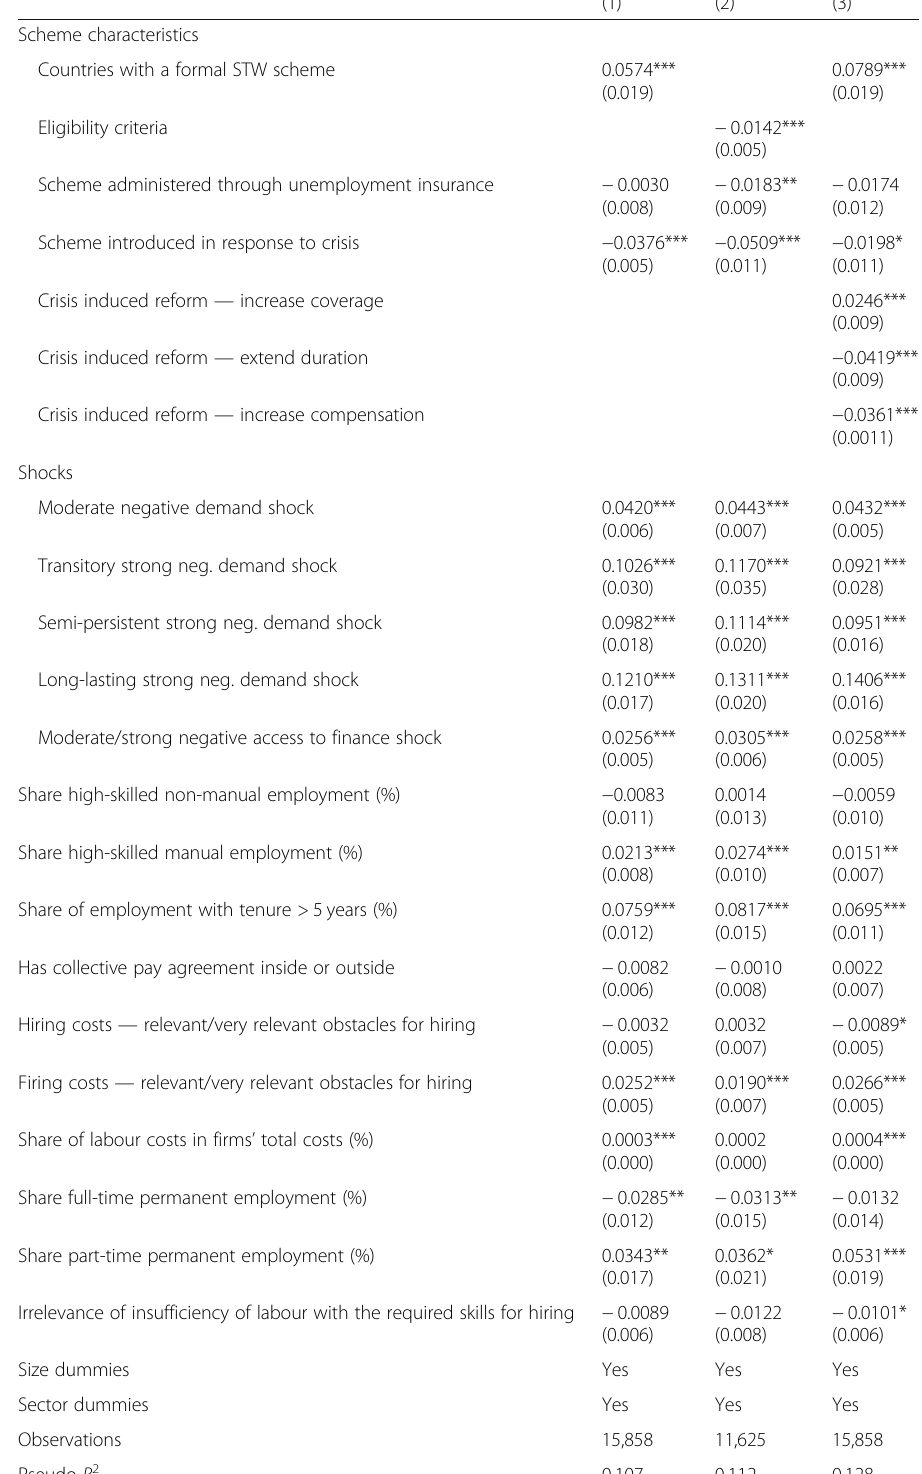
Table 4 Logit results of STW take-up: Firm-specific characteristics + STW scheme